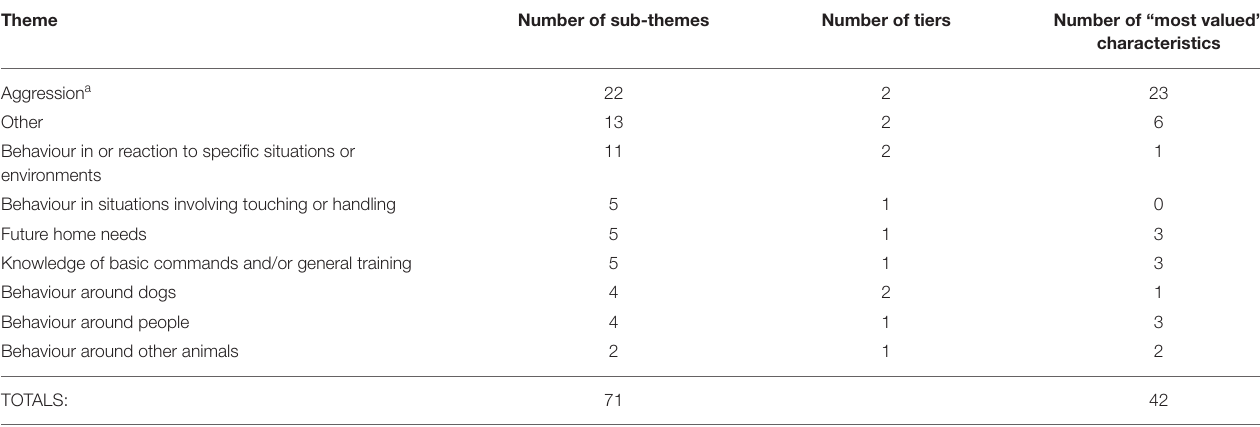
TABLE 2 | Number of sub-themes, tiers, and “most valued” dog characteristics by theme. Theme Number of sub-themes Number of tiers Number of “most valued”